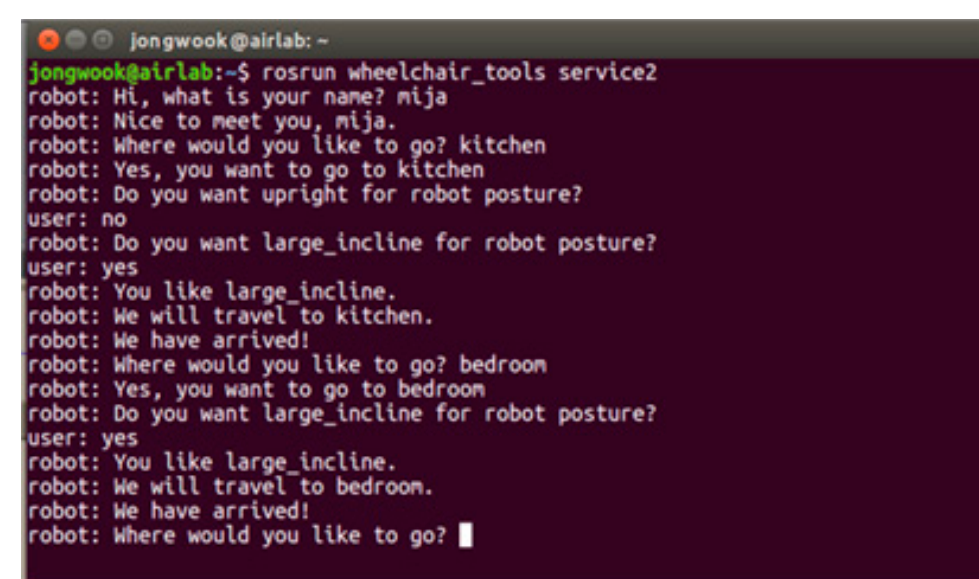
Figure 2. Example of the command inputs of the implemented reinforcement learning.